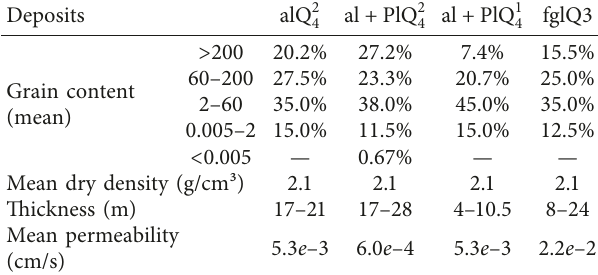
Table 5: Physical properties of the overburden layers in the Qiaoqi